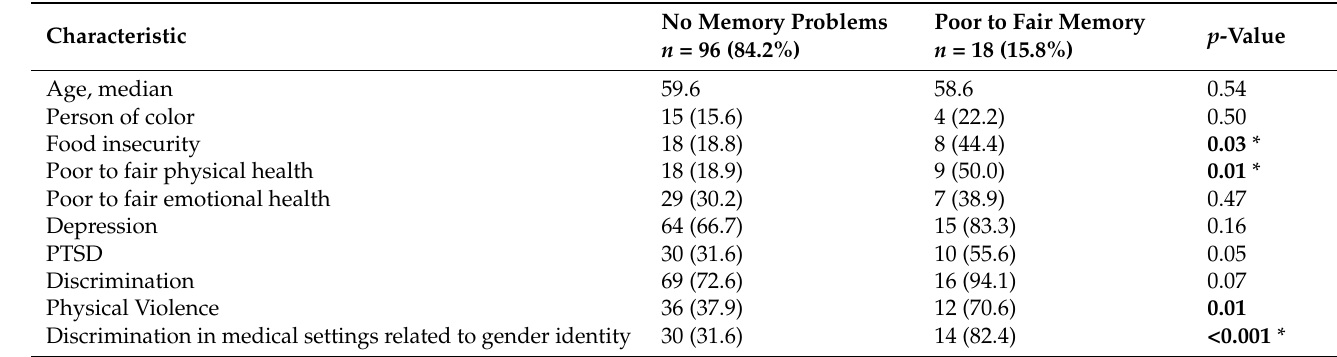
Table 2. Psychosocial Factors Associated with Current Self-reported Poor/Fair Memory in Transgen- der and Nonbinary Older